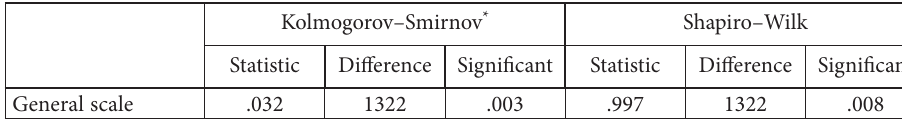
Table 2. Results of the Kolmogorov–Smirnov and Shapiro–Wilk criteria for the variable total scale. Tests of normality (source: created by authors) Kolmogorov–Smirnov * Shapiro–Wilk Statistic Difference Significant Statistic Difference Significant General scale